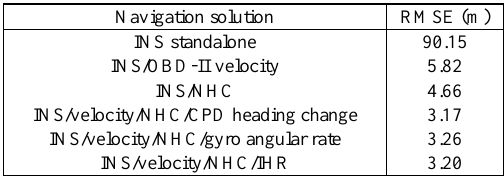
Table 6. Position RMSE for INS/different updates navigation solution method for 90 seconds GNSS signal